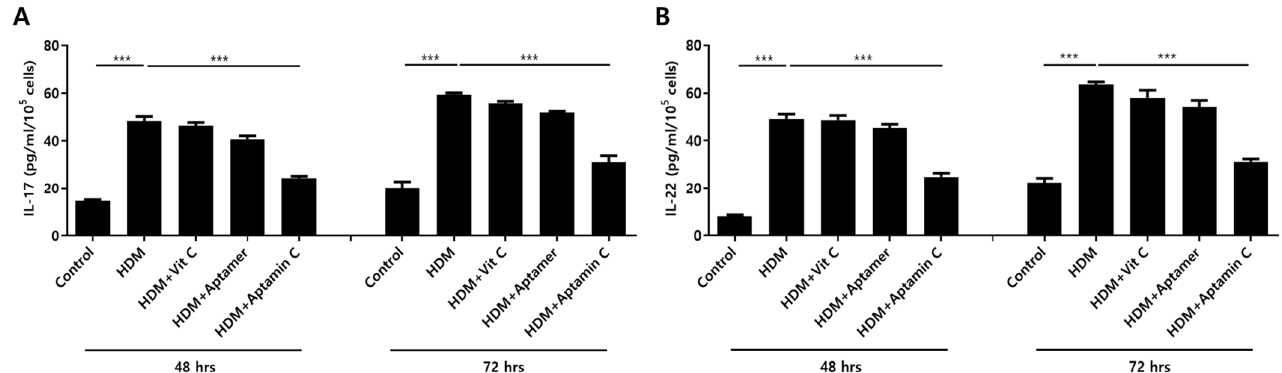
Figure 2. Effects of HDM extract on T cell production of IL-17 and IL-22, and suppression by Aptamin C. T cells isolated from peripheral blood mononuclear cells (PBMCs) and purified with a MACS negative selection system, as described in Materials and Methods, and then treated with 25 µ g/mL of HDM extract, with or without vitamin C (40 µ M), Aptamin (0.09 µ g/mL), or Aptamin C (Vitamin C 40 µ M/Aptamin 0.09 µ g/mL) for 48 or 72 h. The culture supernatants were collected, and the concentrations of IL-17 ( A ) and IL-22 ( B ) were measured by ELISA. Data are presented as the mean ± SD. *** p <